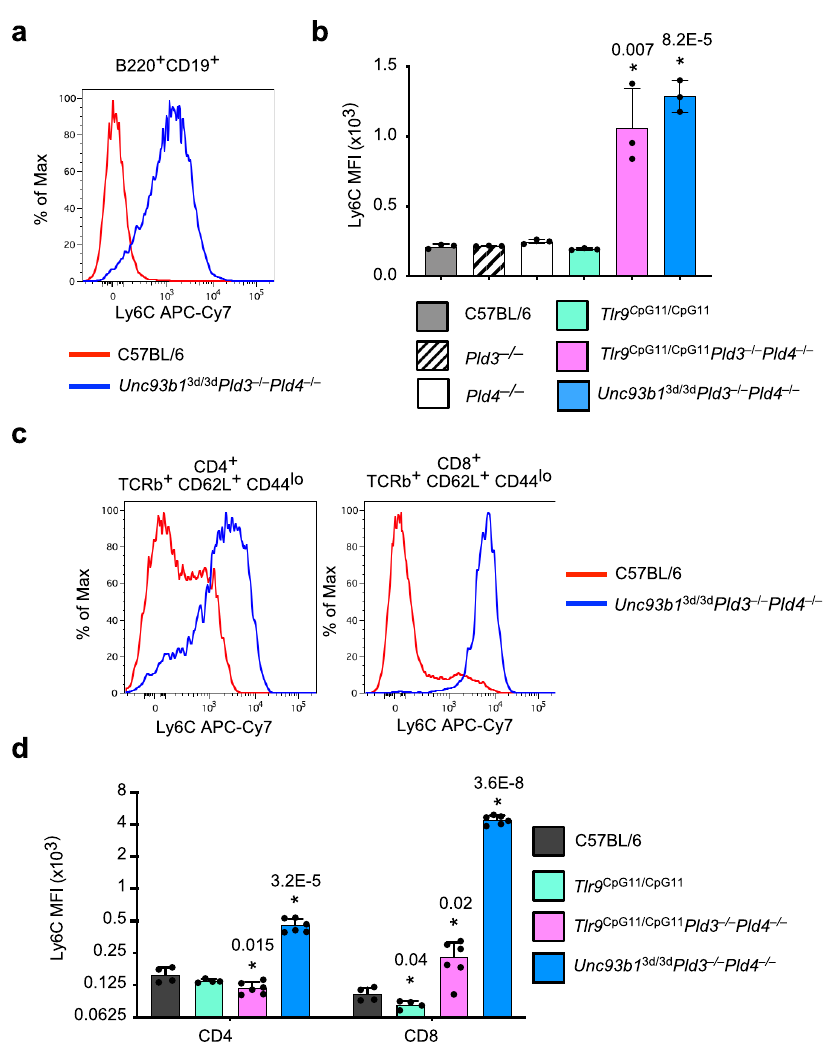
Fig. 7 Elevated Ly6C on Unc93b1 3d/3d Pld3 − / − Pld4 − / − B and T cells. Analysis of Ly6C upregulation on lymphocyte subsets in lymph nodes of mouse strains of the indicated genotypes. a , b Elevated Ly6C on B cells of Unc93b1 3d/3d Pld3 − / − Pld4 − / − and Tlr9 CpG11/CpG11 Pld3 − / − Pld4 − / − mice. c , d Comparison of Ly6C expression on CD4 + T or CD8 + T cells from pooled lymph nodes of the indicated strains. Bar graphs show mean ± SD with each symbol representing an individual mouse. In b , n = 3 independent mice/group. In d, groups were composed of independent mice of the following genotypes: C57BL/6 ( n = 4), Tlr9 CpG11/CpG11 ( n = 4), Tlr9 CpG11/CpG11 Pld3 − / − Pld4 − / − ( n = 6), and Unc93b1 3d/3d Pld3 − / − Pld4 − / − ( n = 6). Unpaired two-tailed T -tests were performed by comparing groups to C57BL/6; asterisks indicate signi fi cant differences with p values given. These experiments were performed twice with similar